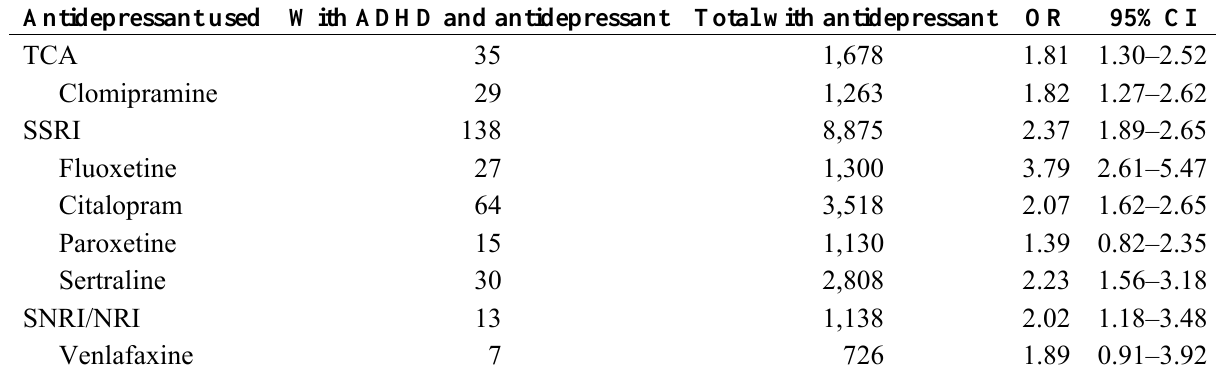
Table 45. Adjusted OR for ADHD after maternal use of various types of antidepressants. Antidepressant